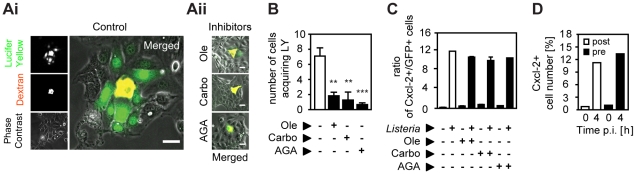
Inhibition of gap junctional transport, cytokine and prostaglandin secretion, or ion fluxes does not affect epithelial intercellular communication.(A) m-ICcl2 cells were microinjected with a mixture of Texas Red-conjugated dextran (red) and the gap junction permissible Lucifer Yellow in the absence (Ai, Control) or presence (Aii) of the gap junction inhibitor oleamide (Ole, 0.1 mM), carbonoxolone (Carbo, 0.01 mM), or α-glycerrhetinic acid (AGA, 0.1 mM). The cellular spread of Lucifer Yellow was visualized 5 min after microinjection by live imaging fluorescence microscopy. Magnification ×400. Phase contrast images were added to visualize single cells. Scale bar, 5 µm. (B) Number of cells acquiring Lucifer Yellow (LY) by gap junction mediated transport after microinjection in the absence or presence of gap junction inhibitors. A minimum of 10 microinjected cells were analysed per experiment; **, p<0.01, ***, p<0.005. (C) m-ICcl2 cells were infected with actA mutant PactA-gfp L. monocytogenes. The ratio of immunolabelled Cxcl-2+ cells to GFP+ (Listeria-infected) cells was determined 4 h after infection in the absence or presence of gap junction inhibitors by flow cytometry. (D) m-ICcl2 cells were infected with actA mutant Psod-gfp L. monocytogenes. The number of immunolabelled Cxcl-2+ cells was determined after the indicated time by flow cytometry. Brefeldin A was added 60 min after (post, white bars) or 30 min prior to (pre, black bars) infection. All infection experiments were performed at a multiplicity of infection of 100∶1. Results are representative for three independent experiments and are presented as mean ± SD (microinjection) or show one representative experiment.